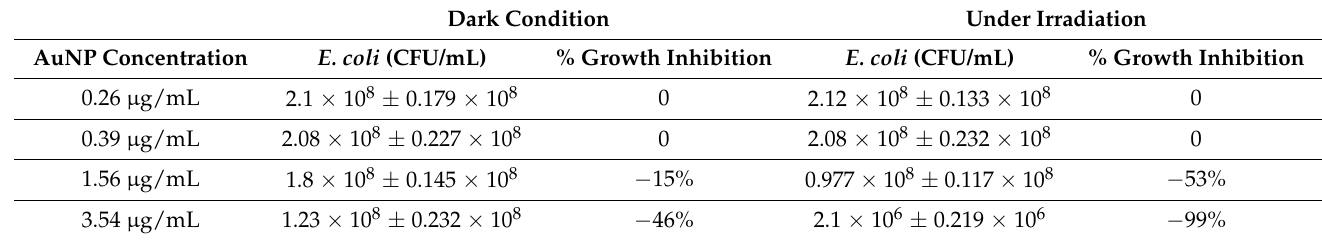
Table 1. E. coli CFU/mL exposed to different concentrations of AuNP, with and without irradiation, and the percentage of growth inhibition after 24 h of growth in incubator. No changes were recorded for the control ( E. coli CFU/mL 2.1 × 10 8 with and without irradiation). The data are reported as the average of three determinations made in duplicate ± standard deviation. Dark Condition Under Irradiation